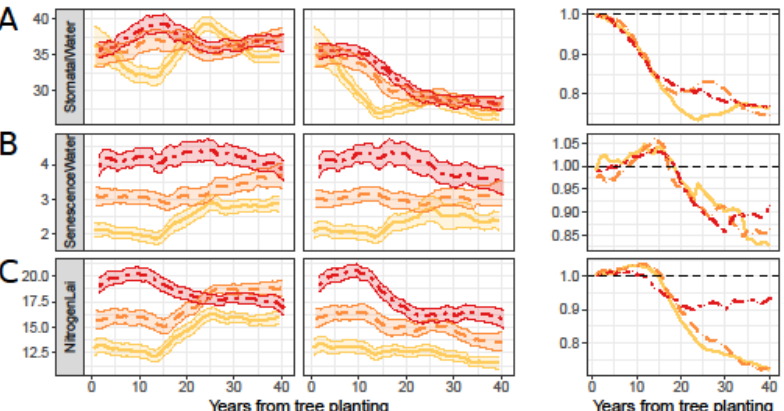
Figure 4. Crop nitrogen and water stress indices in agriculture ( left ), alley cropping ( middle ), and relative values (agroforestry systems (AF)/agriculture (A), right ), in Past (yellow), Present (orange), and Future (red) climates. NitrogenLai for nitrogen stress inducing delayed plant development and slower leaf growth ( A ), SenescenceWater for stress inducing faster senescence ( B ), and StomatalWater for stress, inducing reduced radiation use efficiency and transpiration ( C ). Each scenario is represented by averaging 11 repetitions, while using a moving window of 11 years. Vertical lines represent 95% confidence intervals.